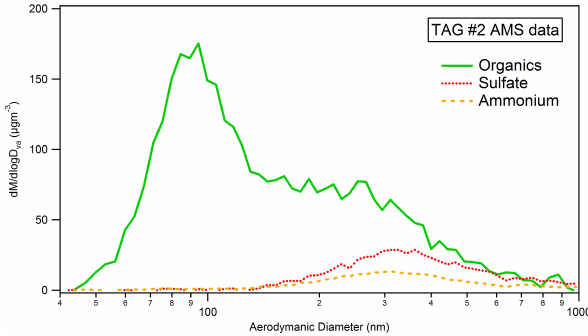
Fig. 4. Average AMS particle size distribution during TAG #2, col- lected 40 to 45min after the addition of ozone. These data have not been wall loss corrected in order to avoid artifacts potentially introduced in the correction